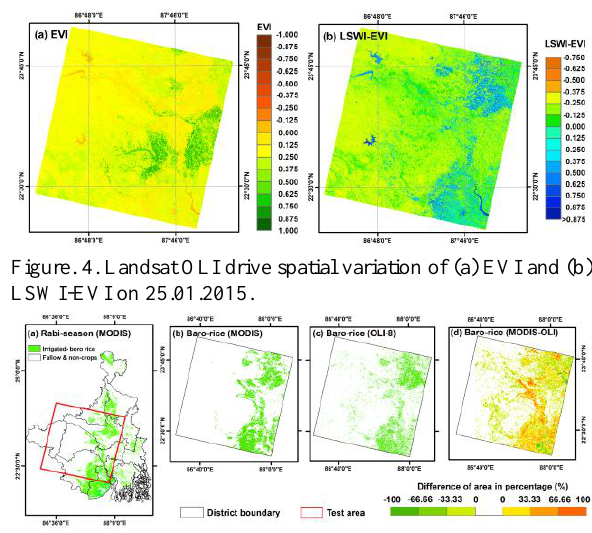
Figure 5. (a) MODIS drive spatial distribution of cropping